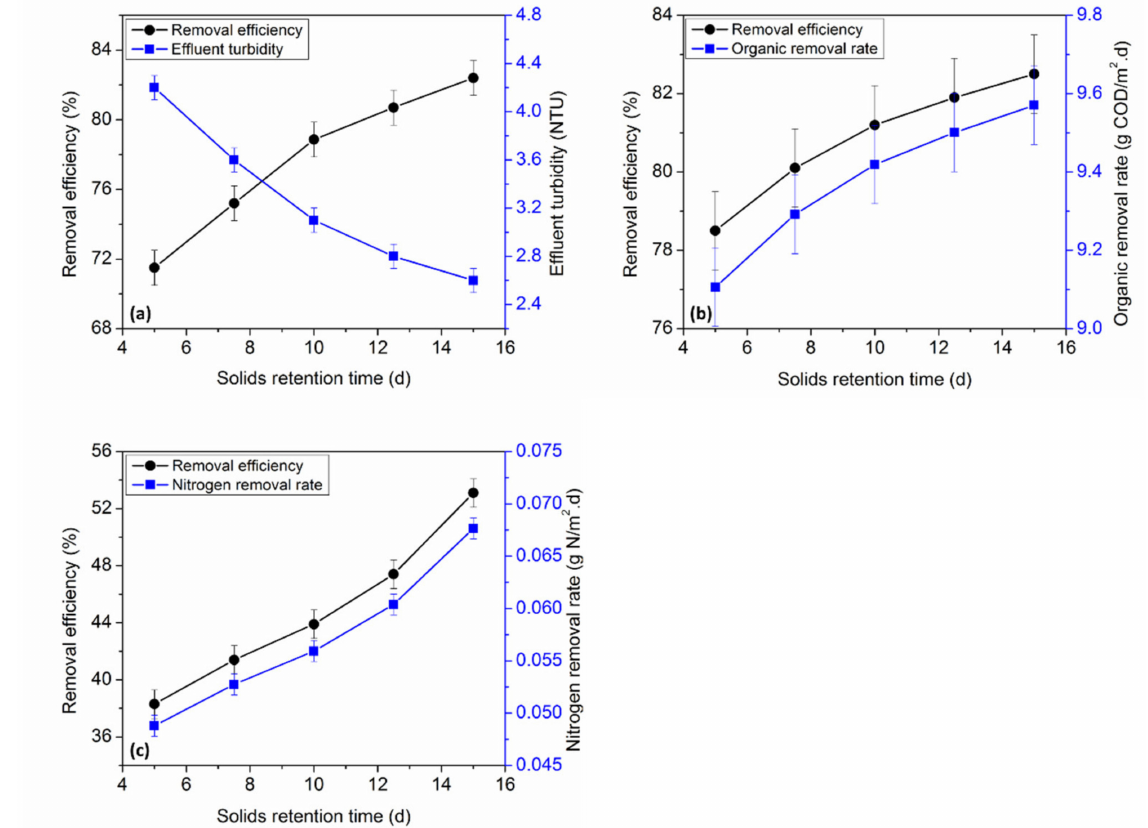
Figure 5. Effect of sludge retention time on ( a ) turbidity, ( b ) COD, and ( c ) TN